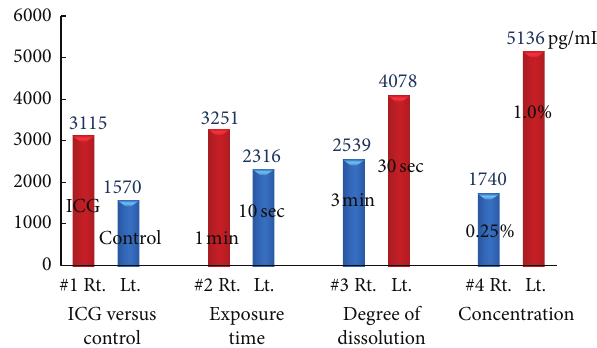
Figure 6: The PGE 2 concentrations in aqueous humor. The rabbit eyes exposed to ICG for a longer period of time (60 seconds), ICG dissolved for only a short time (30 seconds), or a high concentration of ICG (1.00%) resulted in high PGE 2